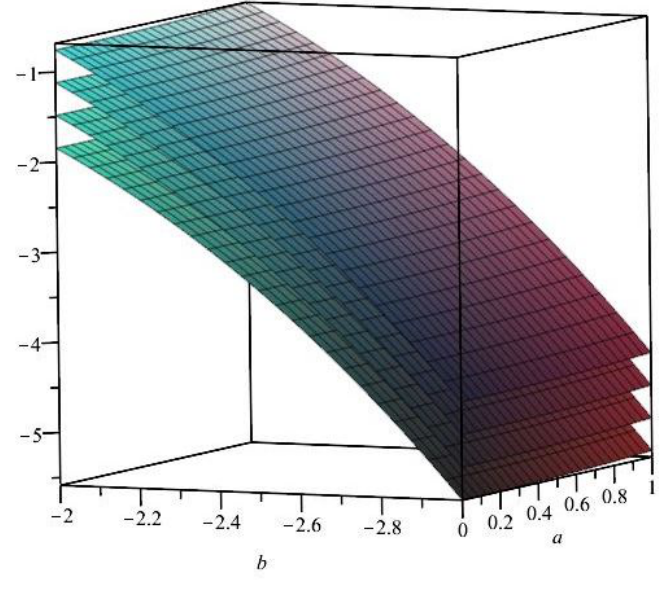
{ a , b ; q } w.r.t. a and b , when q ∈ { 1,11,21,31 }